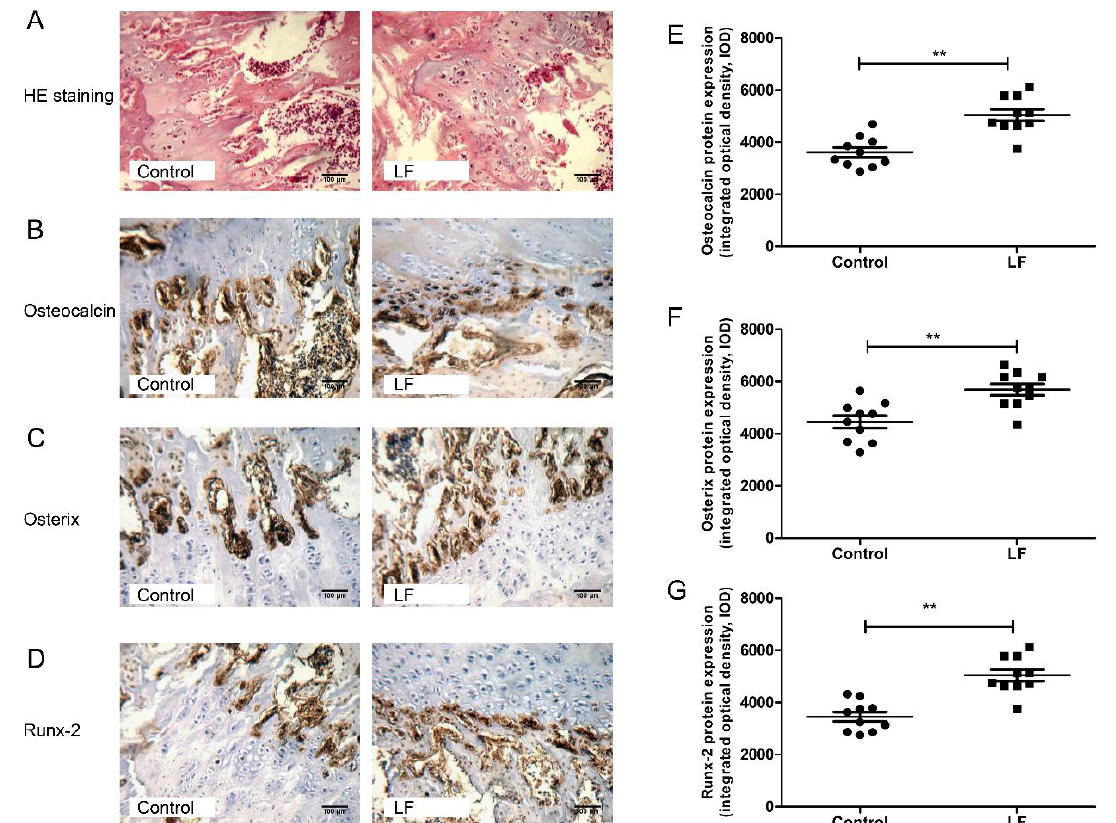
Figure 2. LF supplementation enhanced femoral bone formation of SD rat. ( A ) Representative photomicrographs of femur bone sections of SD rat strained with hematoxylin–eosin staining (×200 magnification, scale bar = 100 μm). (B–D) Representative images for the immunohistochemical staining detection of: osteocalcin ( B ); osterix ( C ); and Runx-2 ( D ). (×200 magnification, scale bar = 100 μm). (E–G) The integrated optical density (IOD) of target protein from immunohistochemistry was quantified by Image-Pro Plus software for: Osteocalcin ( E ); Osterix ( F ); and Runx-2 ( G ). Data are